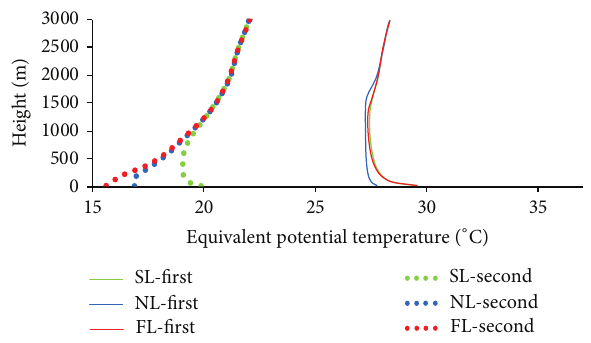
Figure 10: Vertical equivalent potential temperatures of SL, FL, and NL experiments at the grid point with max precipitation caused by the GSL (black dot in Figures 8(a) and 11(a)) over lake in the two